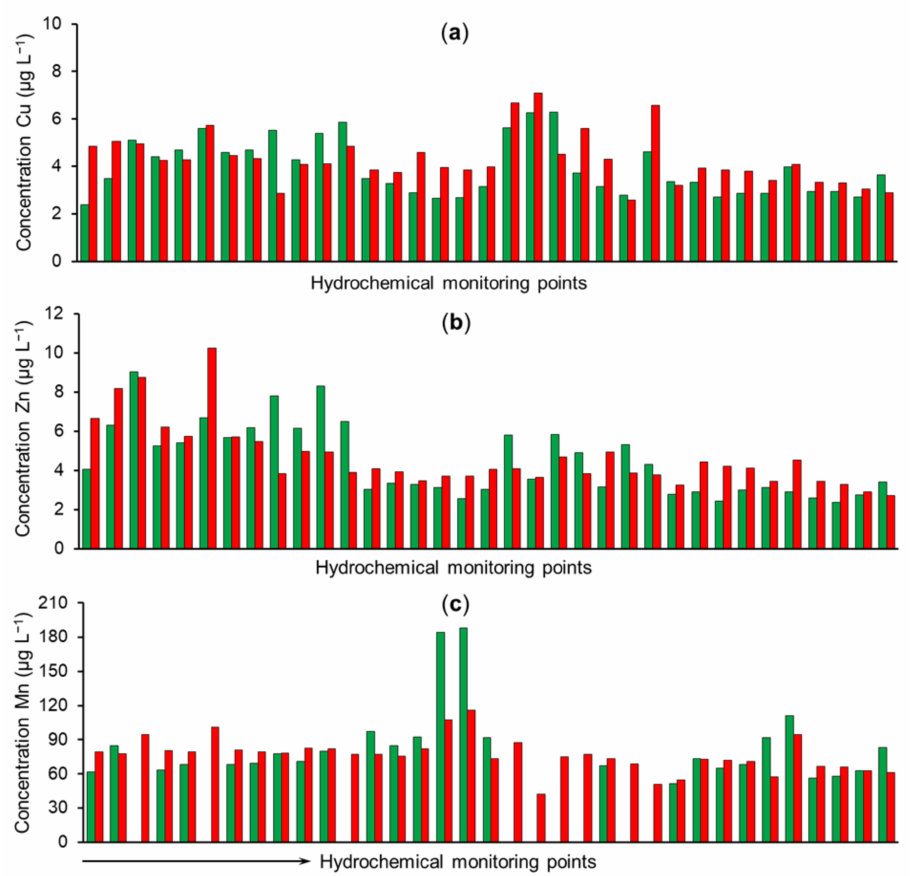
Figure 5. Observed (green) and simulated (red) long-term mean annual heavy metal (HM) concen- trations at the hydrochemical monitoring points located in the order from the upper reaches of the Belaya River toward its inflow into the NKR: ( a ) Cu; ( b ) Zn; ( c ) Mn. The arrow shows the direction of river